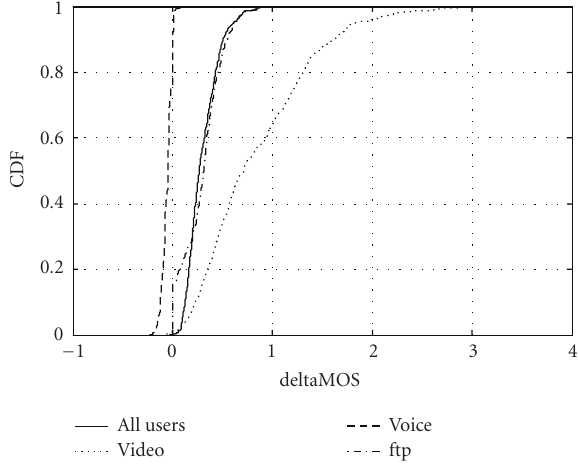
Max throughput Figure 11: Bar plot showing the average MOS over a 30-second simulation